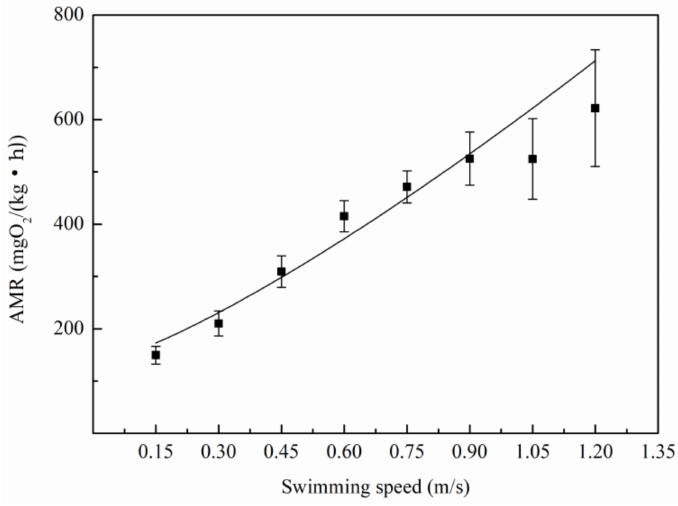
Figure 4. Oxygen consumption rate ( AMR , mean ± SEM) as a function of swimming speed (power function: AMR = 131.24 + 461.26 U s 1.27 , R 2 = 0.948, p <